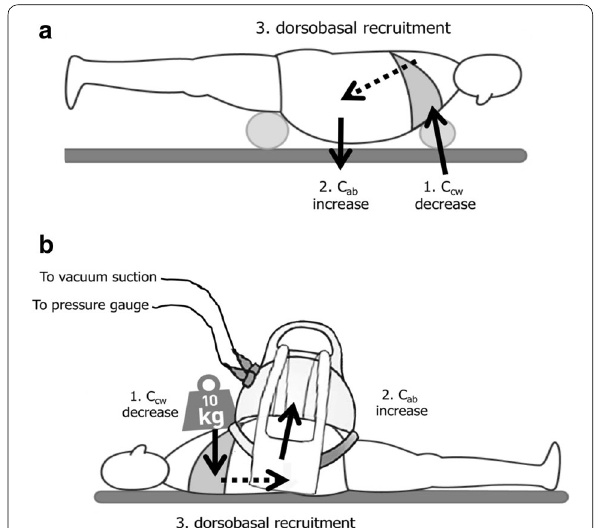
Fig. 4 Effects of positioning on chest and abdominal wall compliance. a Effects of prone positioning with abdominal suspension on chest and abdominal wall compliance. The suspension placed under the chest will reduce chest wall compliance (1) while the abdominal suspension placed at the level of the symphysis will exert a gravitational effect that will increase abdominal wall compliance (2). This will result in recruitment of dorsobasal lung regions (3). b Effects of supine positioning in combination with weight placed on the chest and vacuum bell on the abdomen. The weight placed on the chest will reduce chest wall compliance (1) while the abdominal vacuum bell will increase abdominal wall compliance (2). This will result in recruitment of dorsobasal lung regions